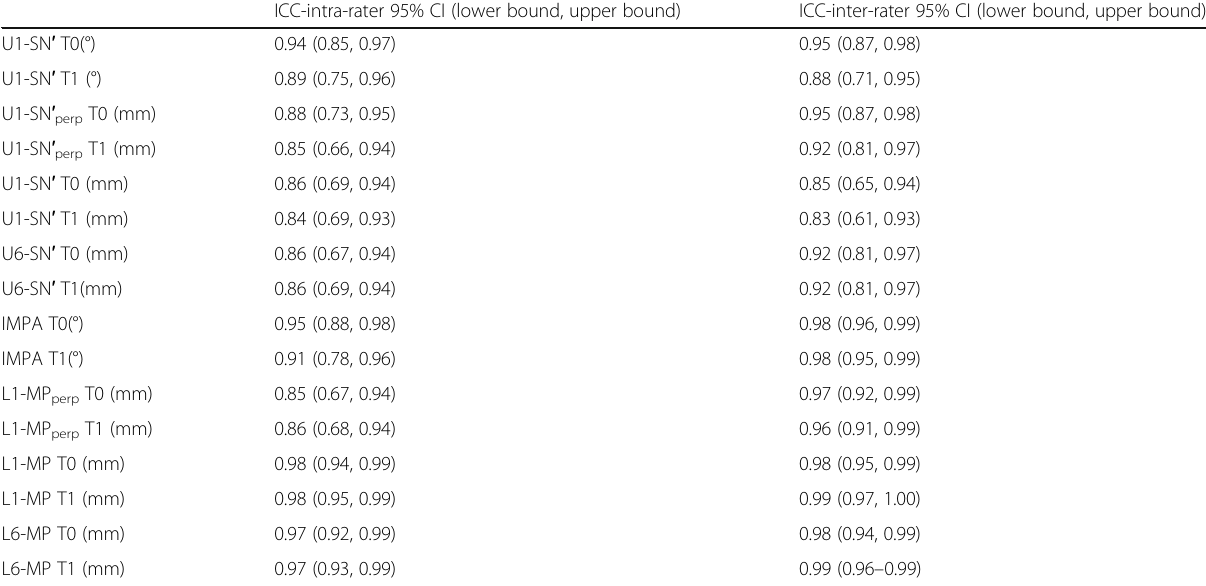
Table 2 Intra-rater and inter-rater reliability ICC-intra-rater 95% CI (lower bound, upper bound) ICC-inter-rater 95% CI (lower bound, upper